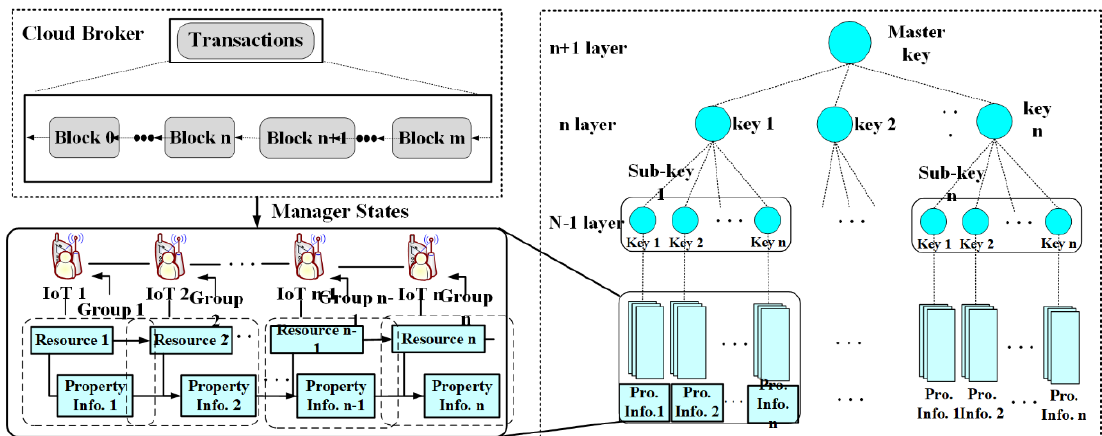
Figure 3. Properties in the creation of blockchain-based IoT data.